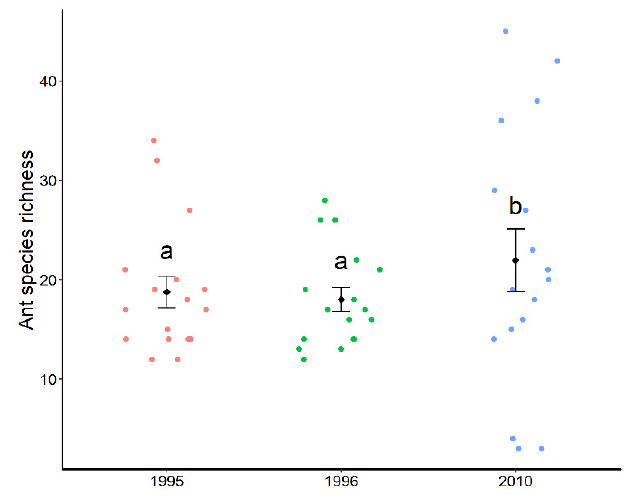
Fig 3. Average ant species richness across studied fragments, located in southeastern Brazilian Atlantic rain forest. In 2010, ant species richness was higher than in 1995 and 1996 (p = 0.002). Each point represents a fragment sampled in the correspondent year. The black lozenges represent the average and the bars represent the standard error. Different letters represent significant differences at alfa = 0.05.